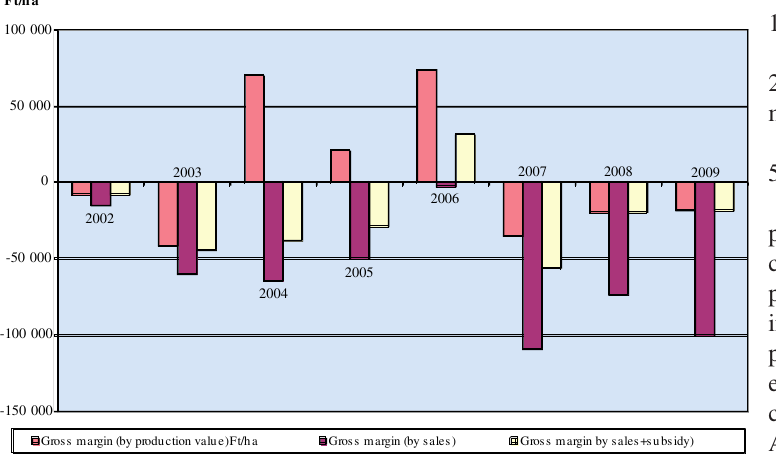
Figure 3. The changes of the gross margin of plum